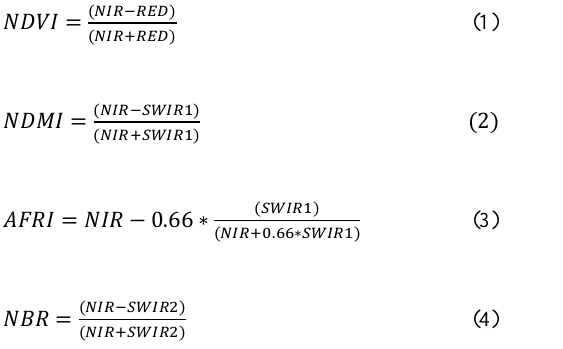
Fig. 3: Mean NDVI for 30 random points taken in each land cover class of Mizoram area from year